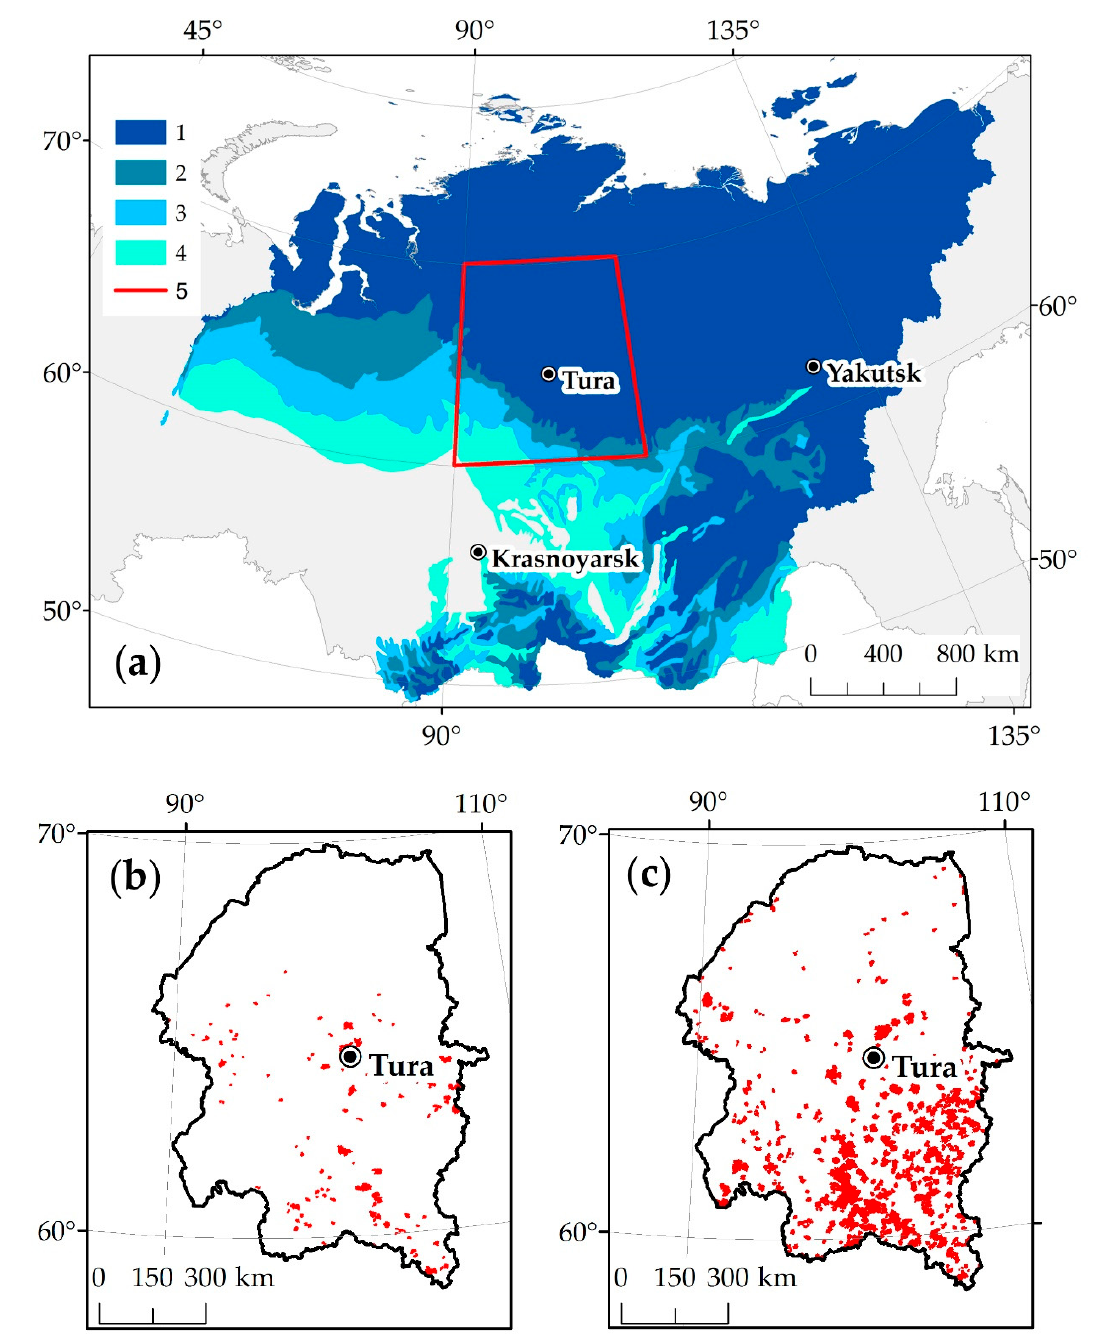
Figure 1. Study area: permafrost zone in Central Siberia according to Brown et al. [22] ( a ) Large-scale wildfire disturbances (S > 5000 ha) in the Evenkia region in 2000–2009 ( b ) and in 2010–2019. ( c ) Types of permafrost: 1—continuous (90–100% of territory); 2—discontinuous (50–90%); 3—sporadic (10–50%); 4—isolated patches (0–10%); 5—study area.